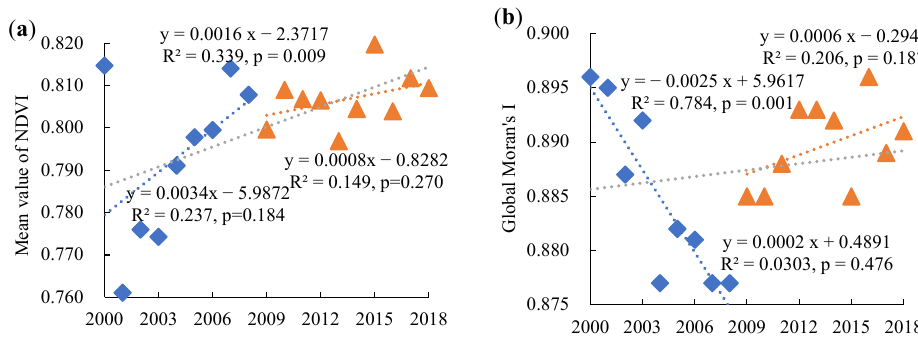
p=0.184y = 0.0008x − 0.8282 R² = 0.149, y = 0.0034x − 5.9872 R² = 0.237,